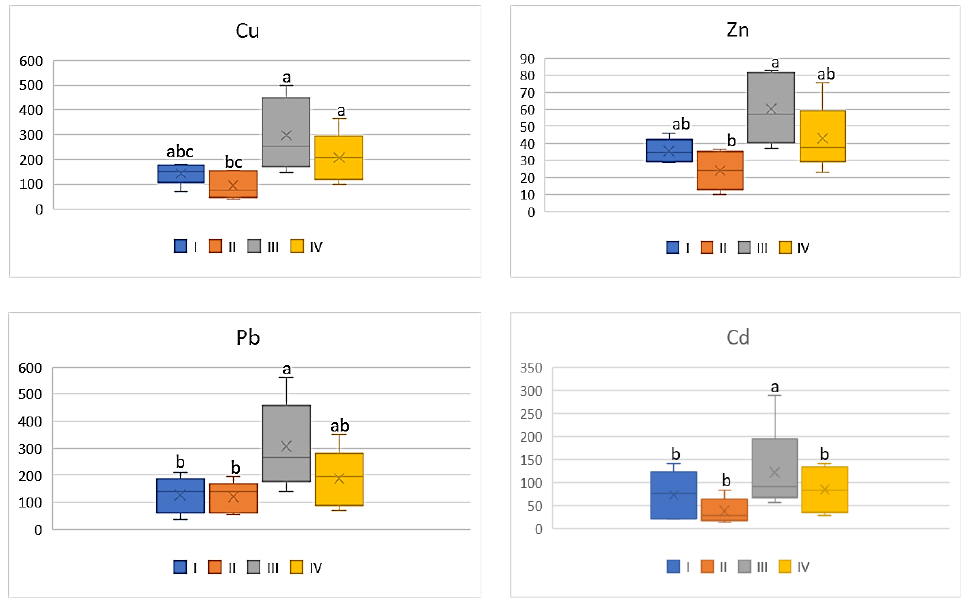
Figure 9. HRI values for tomato depending on the metal and study zones. The same letters mean no significant differences between the values.